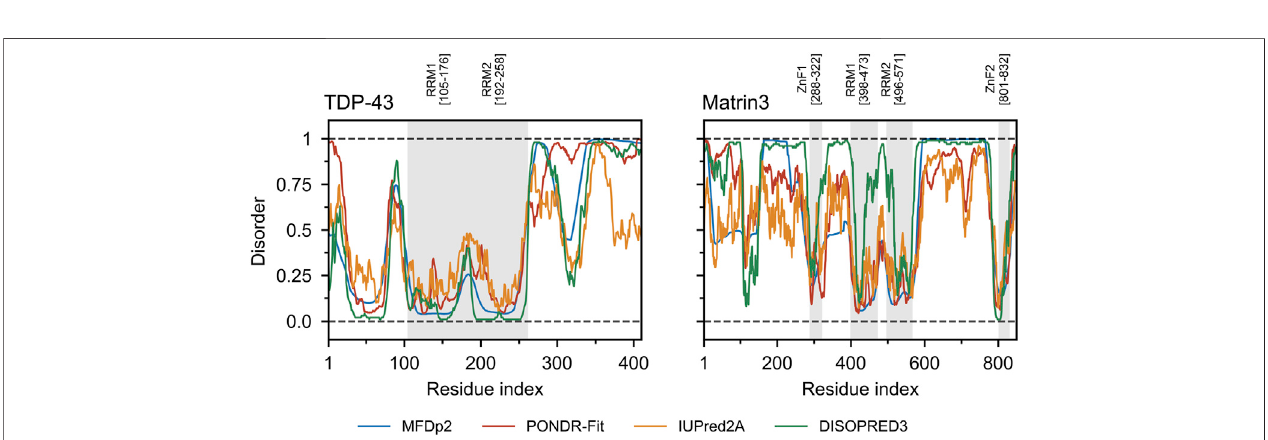
FIGURE 5 | TDP-43 and Matrin3 disorder prediction. Four webservers MFDp2 (Mizianty et al., 2010; Mizianty et al., 2011; Mizianty et al., 2013), PONDR-Fit (Xue et al., 2010), IUPred2A (Mészáros et al., 2018), and DISOPRED3 (Jones and Cozzetto, 2014; Buchan and Jones, 2019) were chosen based on documented performance (Nielsen and Mulder, 2019). A con fi dence value below 0.5 indicates a residue is likely to belong to an ordered region, while a value above 0.5 indicates a residue is likely to belong to a disordered region. Motifs are indicated and colored in grey as a background on the plot. Motif assignment is based on the InterPro (Blum et al., 2020) and numerical values indicate the